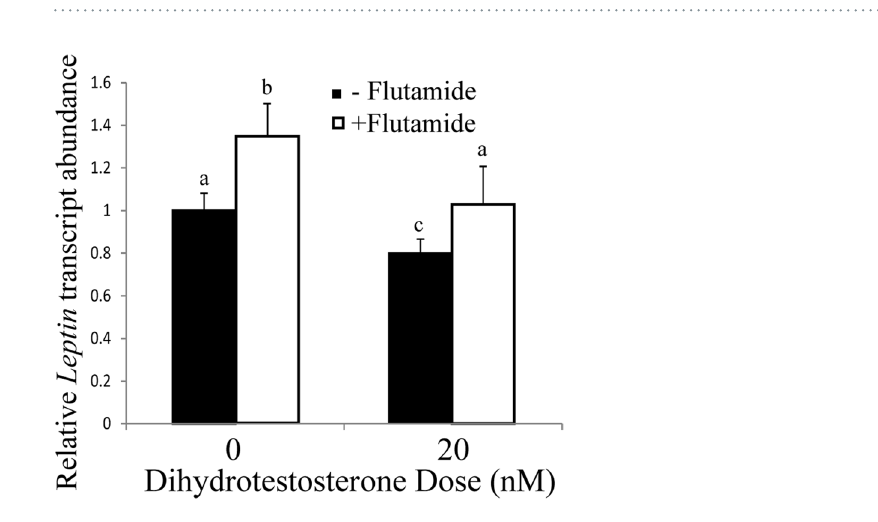
Figure 1. Lep transcript abundance decreased at elevated DHT levels. 3T3-L1 cells were treated with the indicated dose of DHT for 24 hours. Leptin transcripts were measured by qRT-PCR and normalized to an 18 S rRNA control. The transcript abundance relative to untreated controls is reported as mean ± S.E.M with n ≥ 8 biological replicates; * Denotes p-value ≤ 0.05 when compared to control with 2-sample, independent Student’s t-tests.